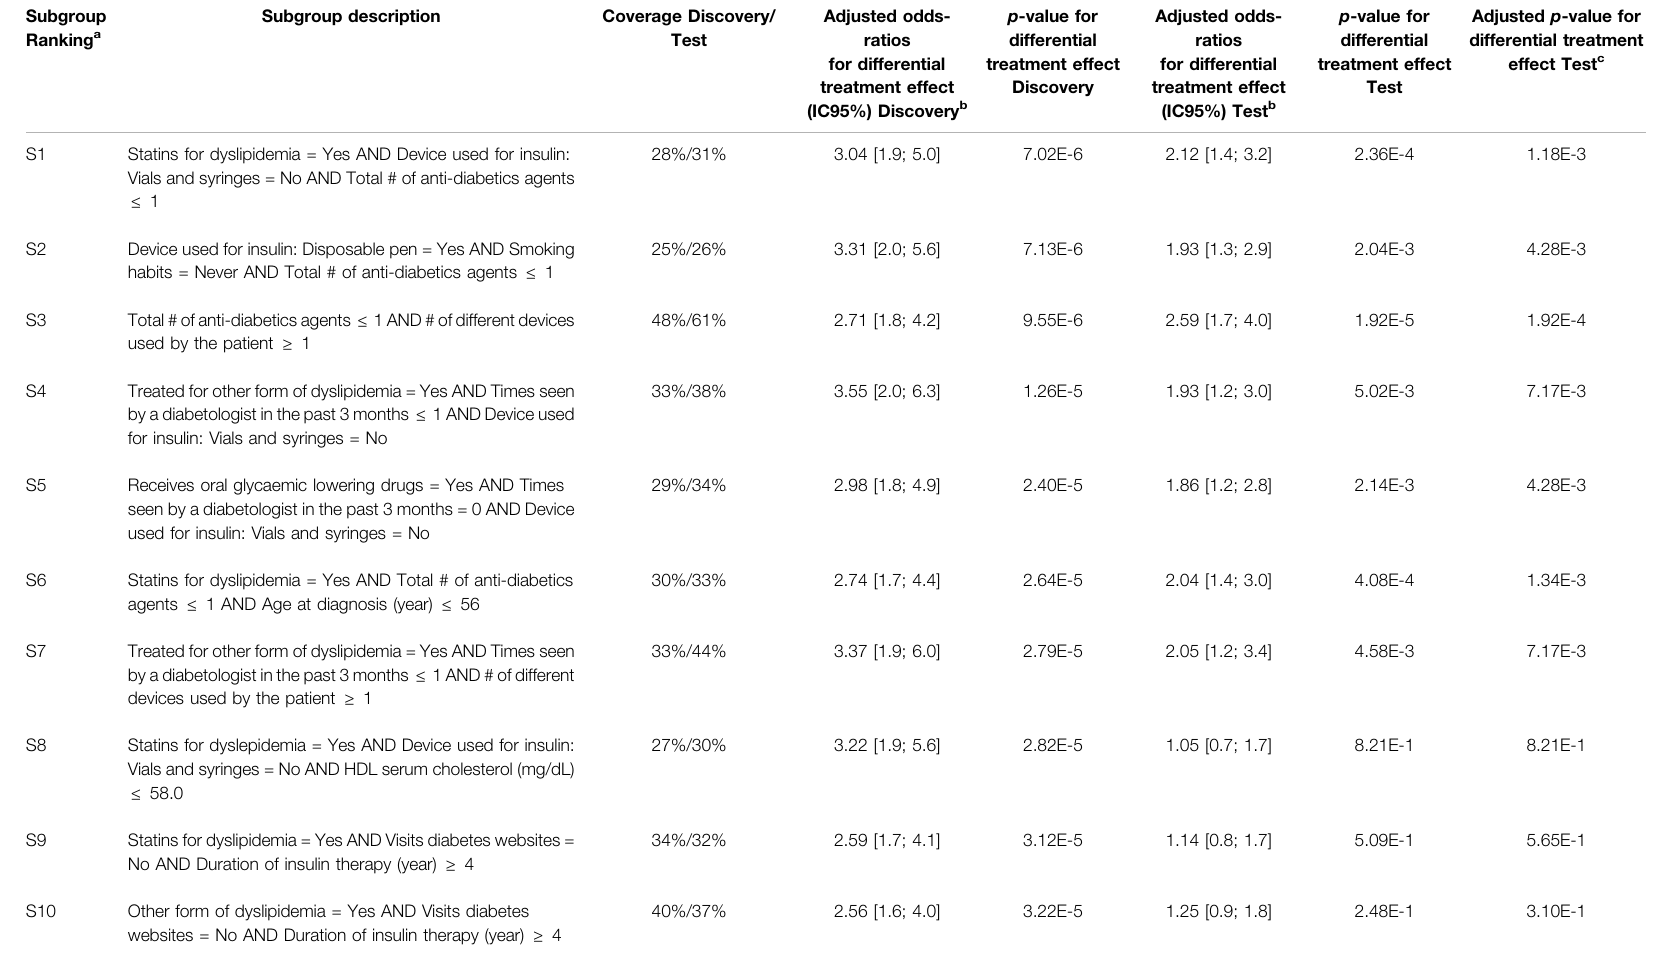
TABLE 3 | Q-Finder results on the detection of predictive factors describing patients with a higher risk than the others in experiencing hypoglycemia under Premixed insulin than under Basal insulin (with or without Prandial insulin). Subgroup Ranking